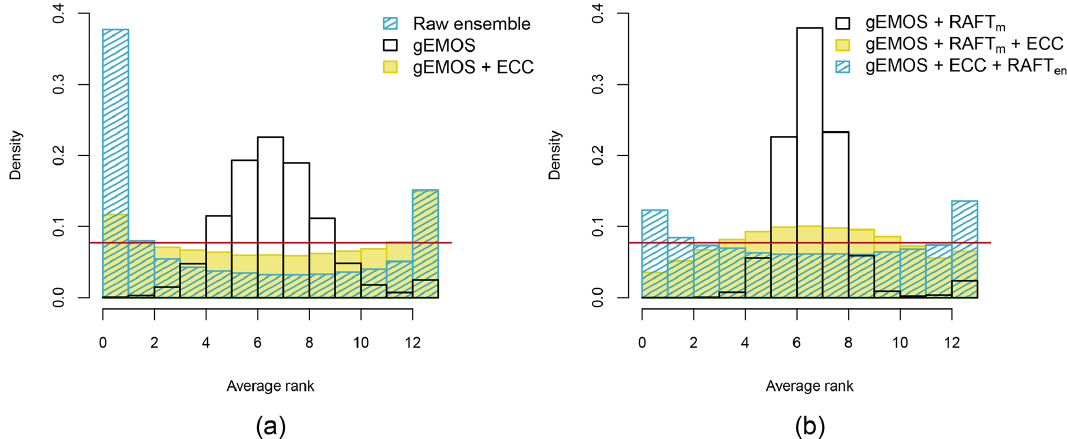
Figure 6. Average rank histogram for different combinations of post-processing methods. Data points are aggregated over all sites, model runs and lead times. All RAFT forecasts have been adjusted using the observation measured 2h